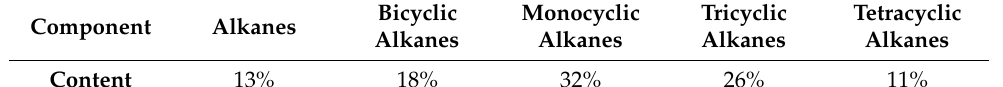
Table 1. Mass composition of naphthenic mineral oil.